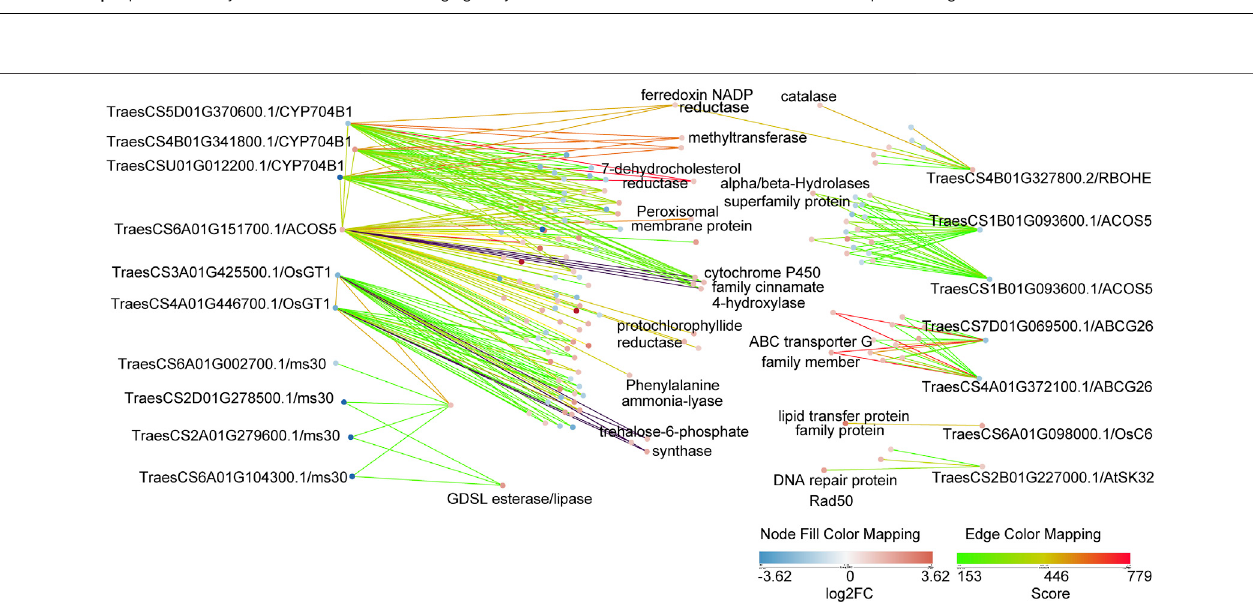
FIGURE 6 | Protein interaction networks of 18 putative GMS orthologs genes in wheat. These 18 proteins were DEPs in bi-nucleate stage. The strength of protein interaction is represented by edge color, and the up-down relationship of DEPs is represented by node color. In addition, the putative GMS homologous genes were labeled in the outer part of the fi gure, and the gene annotations of some of their interacting proteins were labeled in the inner part of the fi gure.